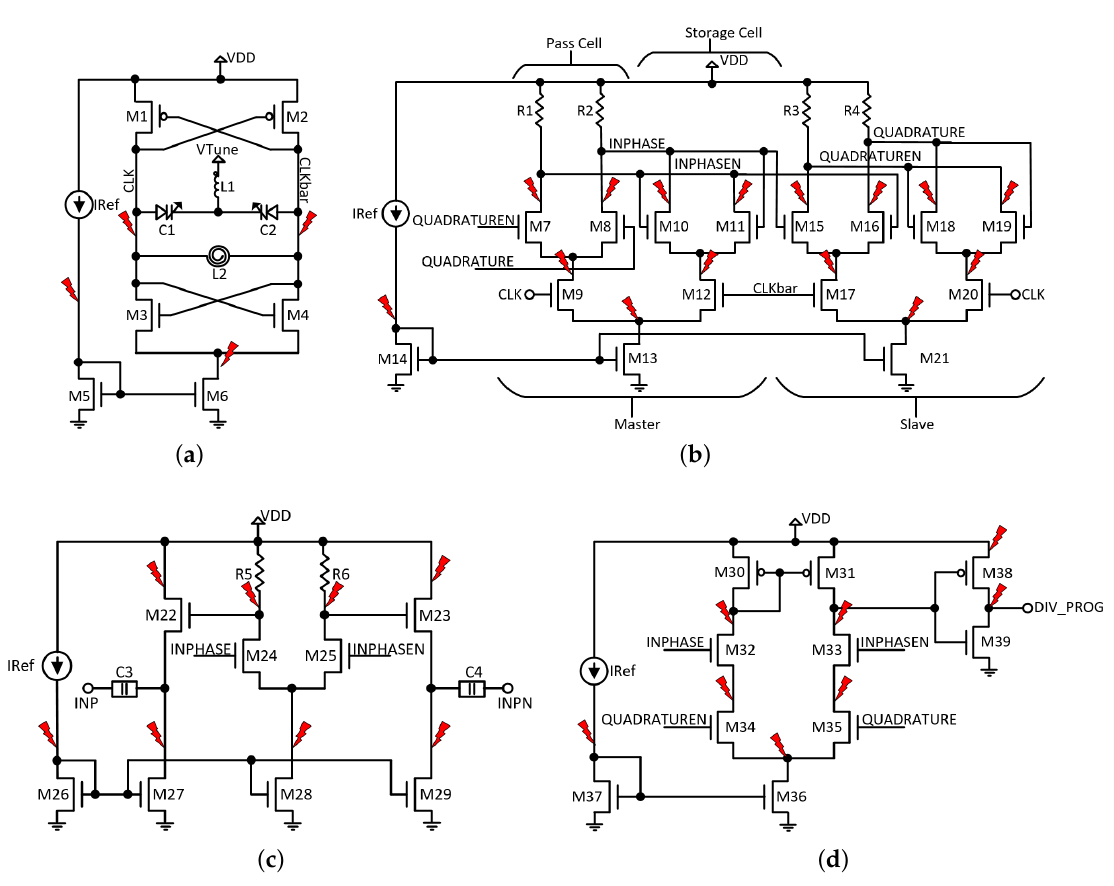
Figure 2. Schematic of the frequency synthesizer most vulnerable circuits. ( a ) Voltage controlled oscillator (VCO); ( b ) Frequency divider by two (FD2); ( c ) Mixer buffer (MB); ( d ) Current-mode logic to CMOS (CML2CMOS)